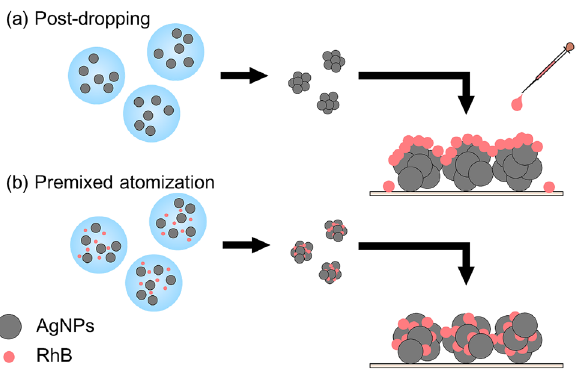
Figure 8. ( a ) Post-dropping and ( b ) premixed atomization routes for comparison of the hot spots they